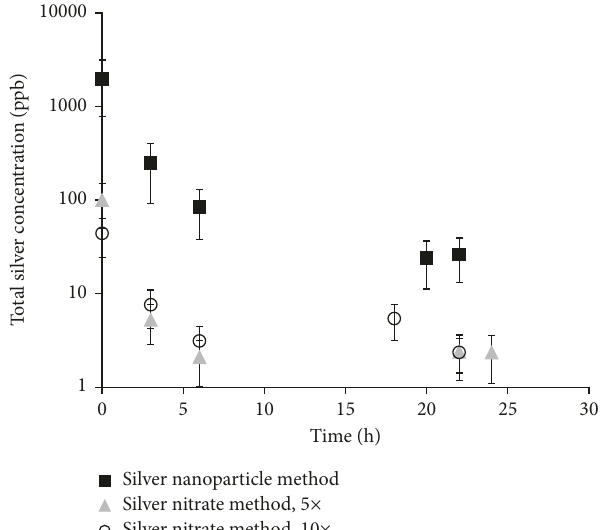
Figure 4: Total silver concentration as a function of time in effluent from silver-ceramic filter media. Data is for three filter types with varying silver application methods and amounts. Error bars show one standard error above and below the